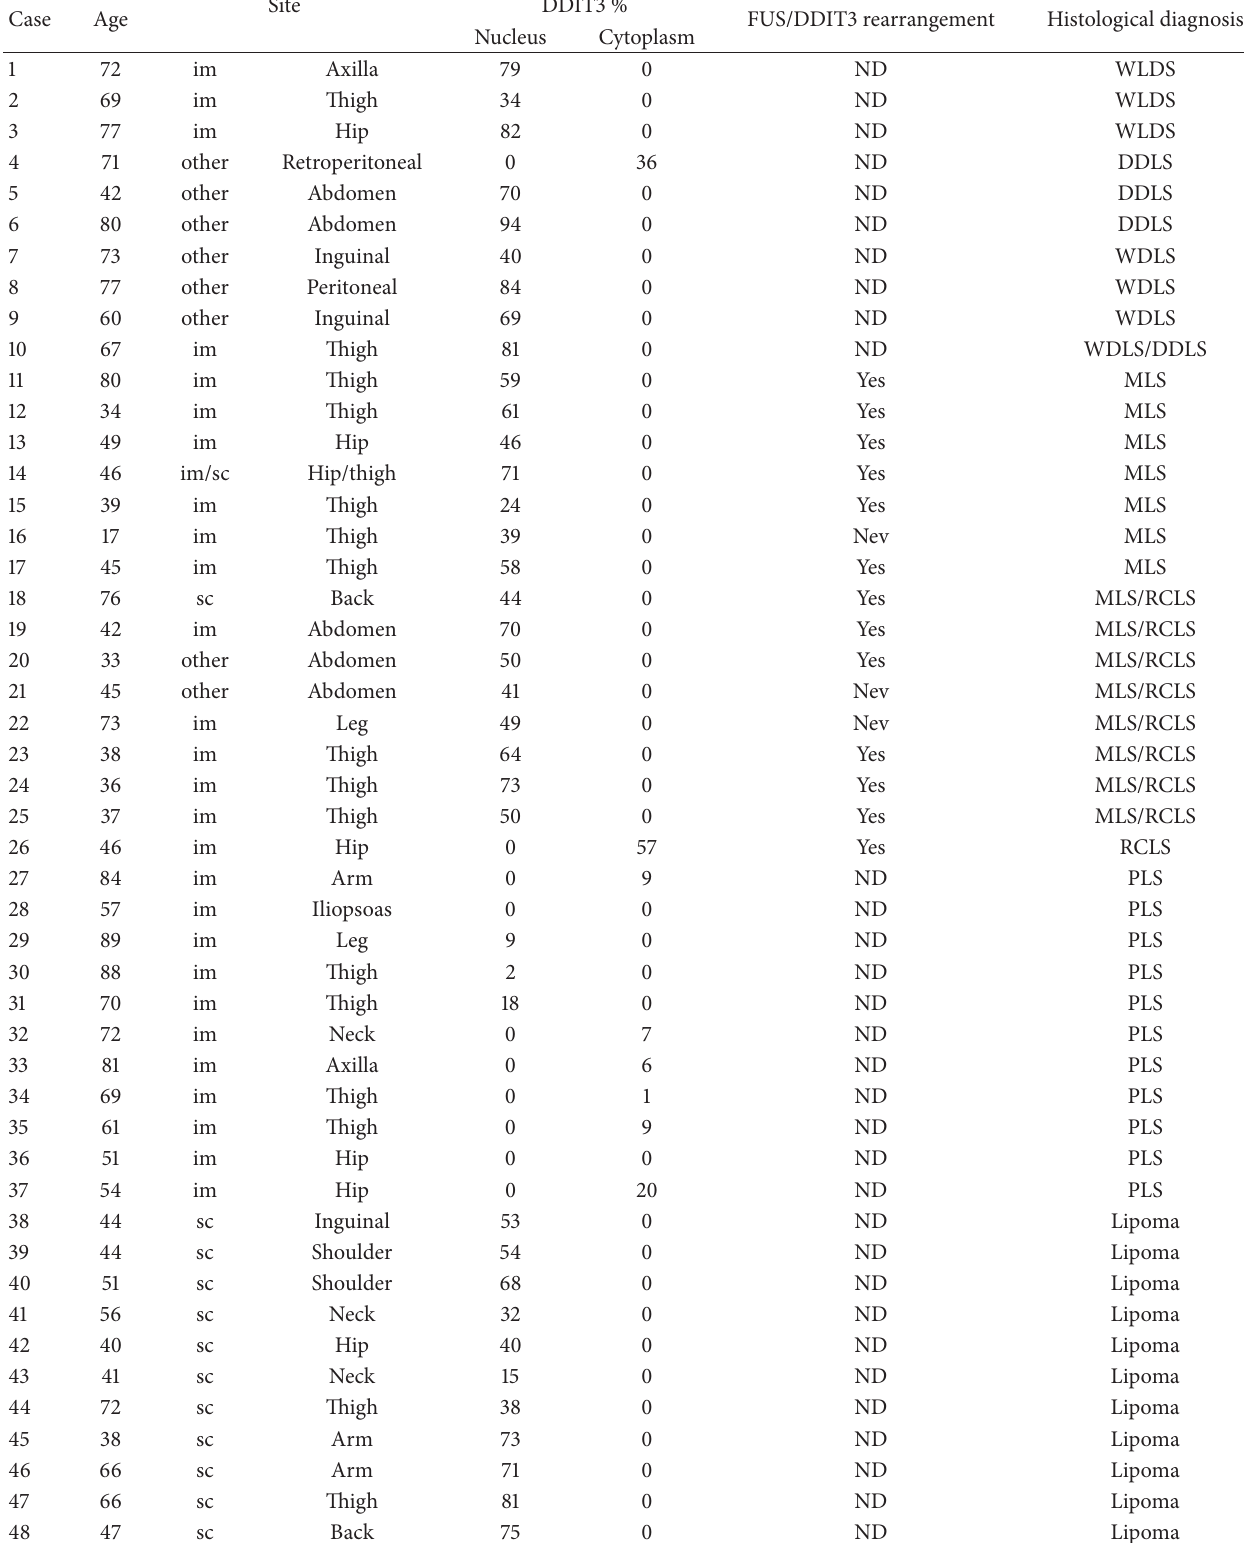
Table 1: Cases and DDIT3